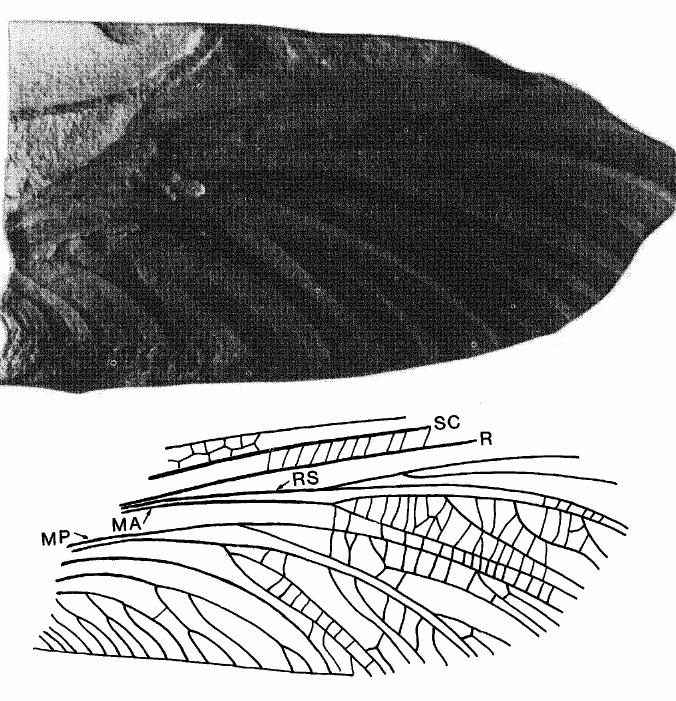
Fig. 1. Syntonoptera schucherti Handlirsch, fore wing. Upper figure: photograph of holotype, No. YPMI9, Peabody Museum, Yale University. Length of wing frag- ment, 80 mm. Lower figure, venational pattern of